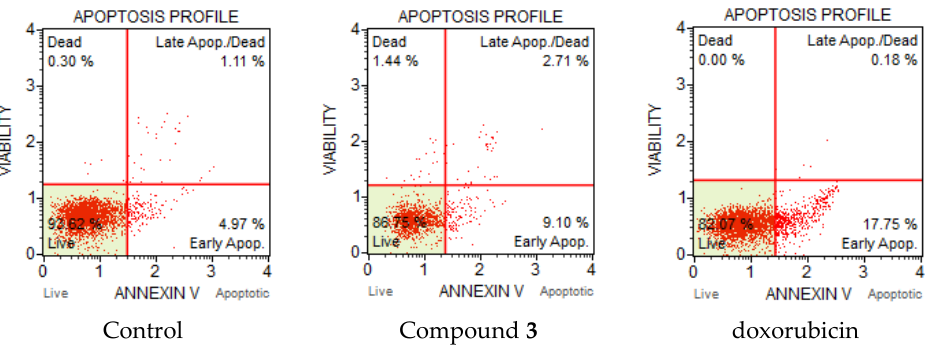
Figure 4. Apoptotic profile of HCT-116 cancer cells after treatment with compound 3 and doxorubicin at 2 × IC 50 ( μM ) concentration after 24 h.